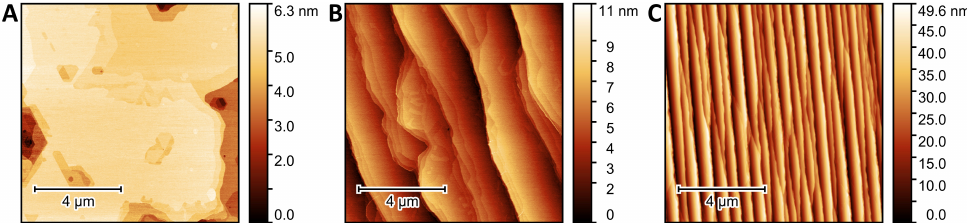
Figure 1. 10 × 10 µ m 2 AFM topography images showing morphologies of as-grown ( A ) nominally monolayer EG on on-axis, ( B ) hydrogen-intercalated QFS bilayer EG on on-axis, and ( C ) multilayer EG on 4 ◦ off-axis SiC(0001).